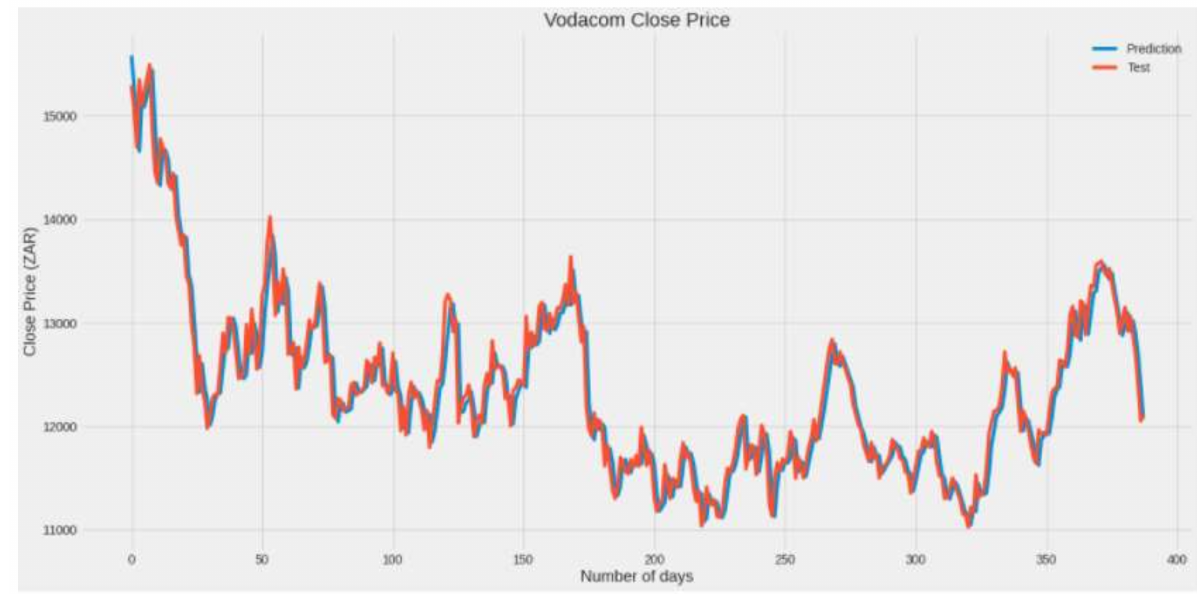
Figure 2. Stacked LSTM Experiment 2.1.